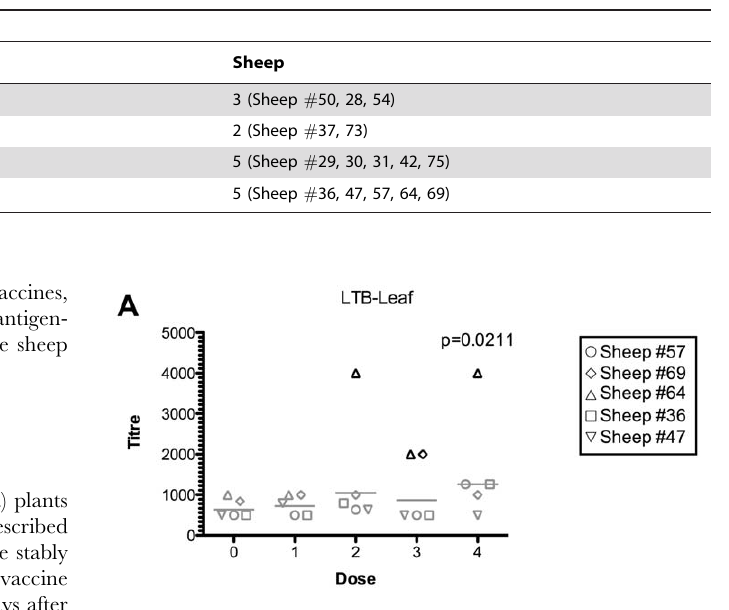
Table 1. Oral immunisation treatments and number of sheep assigned to each group.